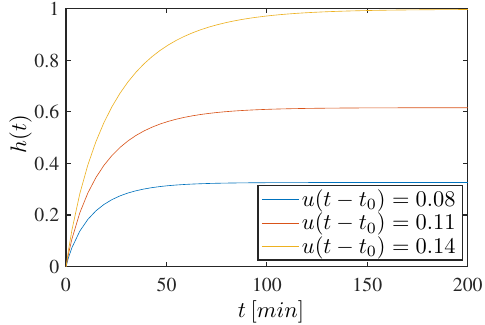
Figure 22. Plant response.